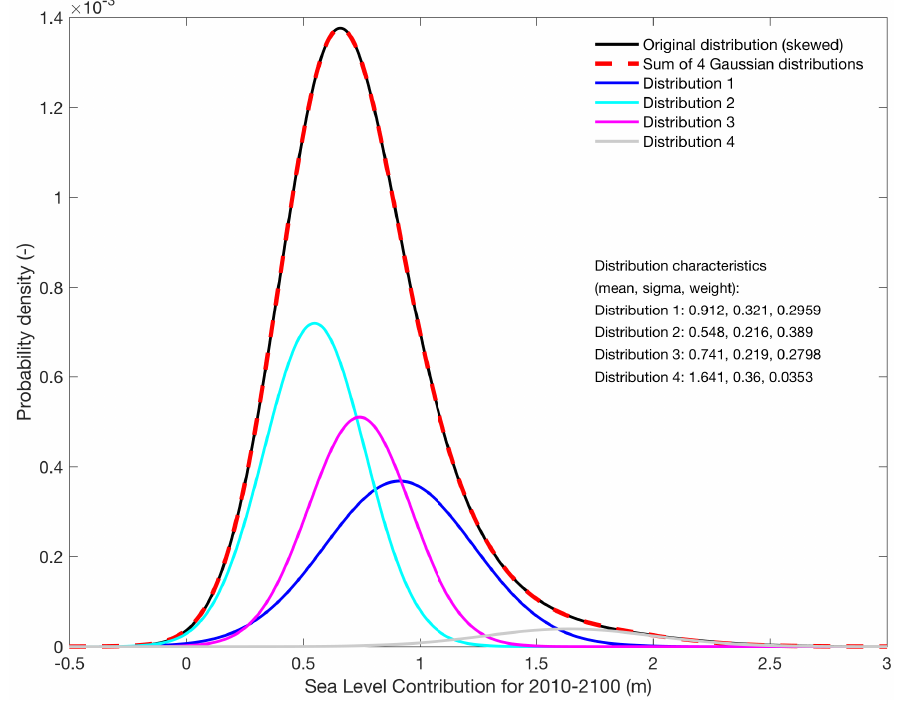
Figure 4. Example of a skewed sea-level uncertainty distribution (black), broken down into a set of four normal distributions (blue), which together describe the original distribution best (red